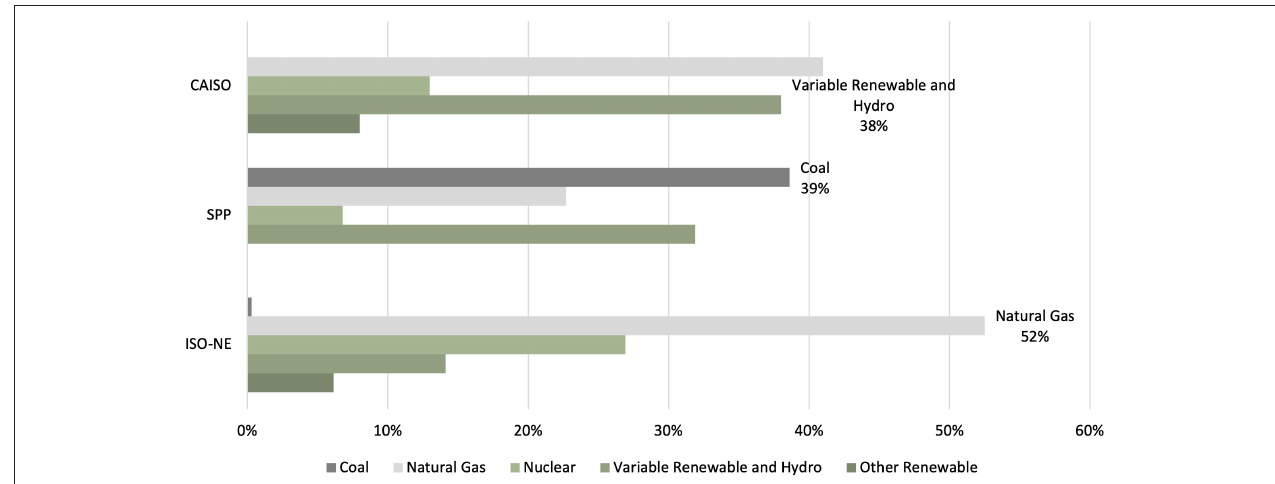
FIGURE 2 | Share of energy generation by resource for selected regional transmission organizations. Sources: California Independent System Operator (2021a), Independent System Operator of New England (2021b), Southwest Power Pool